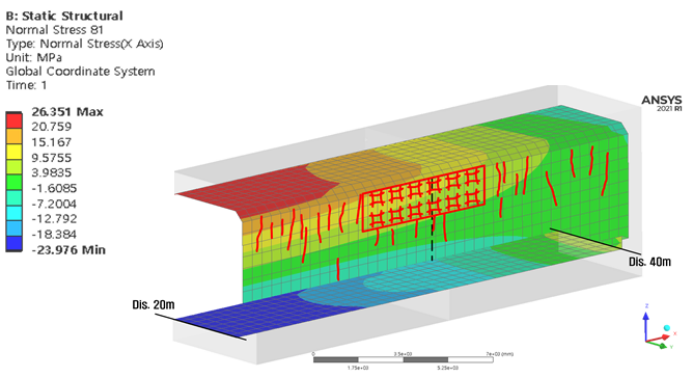
Figure 9. Comparison between the visual inspection mesh diagram and analysis results (Cell 1 wall) for the heaving section.